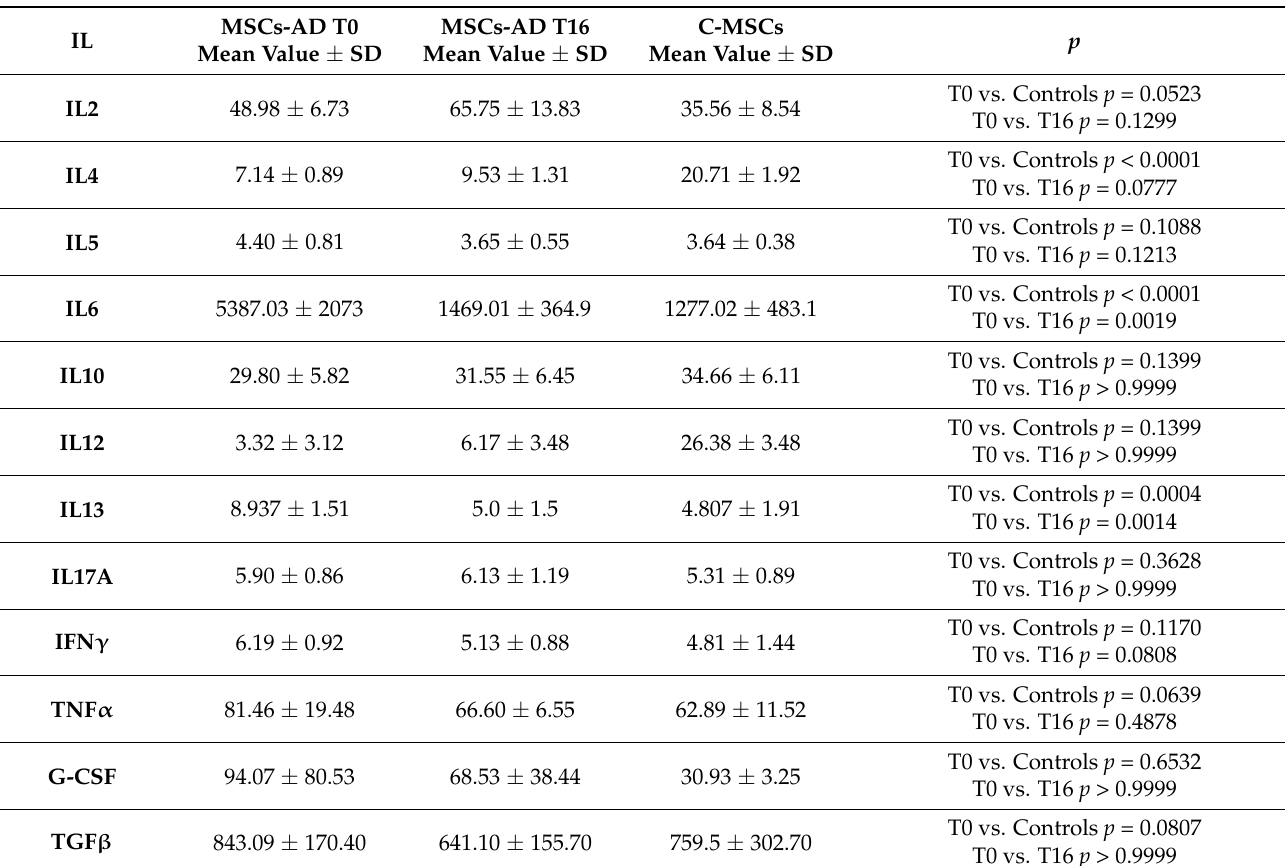
Table 3. Th1, Th2, Th17 cytokines expression by ELISA in MSCs from healthy controls (C-MSCs) and MSCs from AD patients (AD-MSCs) at T0 and T16.